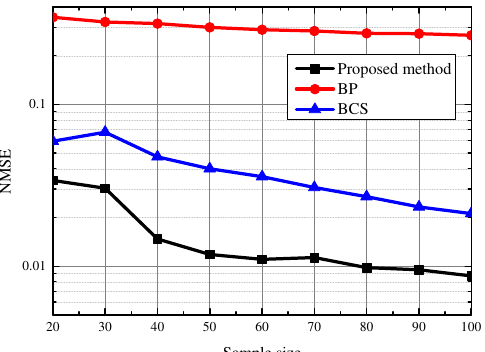
Figure 7. NMSE of GS estimation of different algorithms under different sample